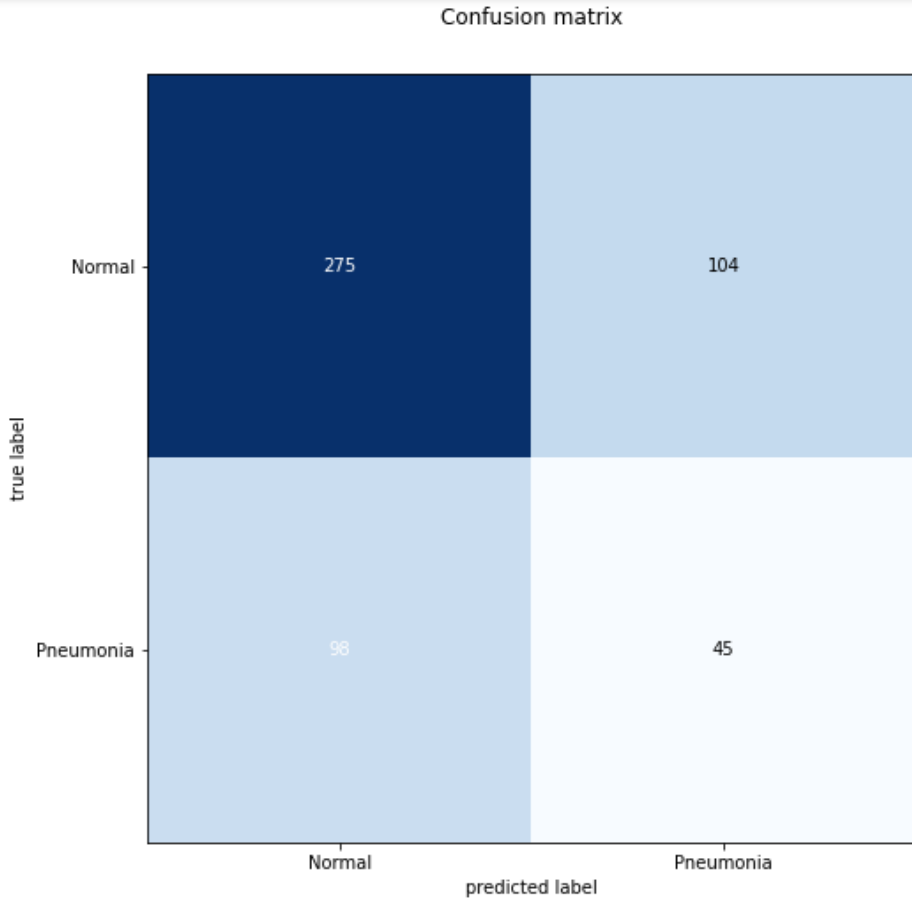
Figure 8. Confusion matrix for the Chest X-ray (Pneumonia)